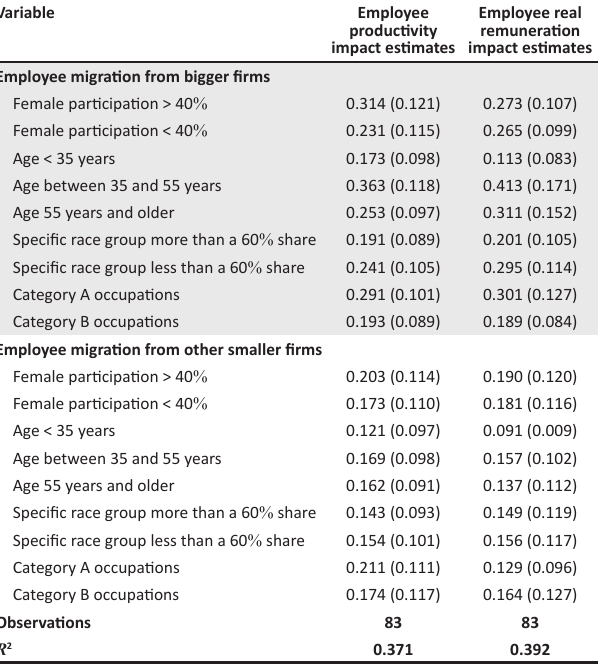
TABLE 2: Panel data estimates for the impact of inbound employee migration on employee productivity taking employee diversity dimensions into consideration. Variable